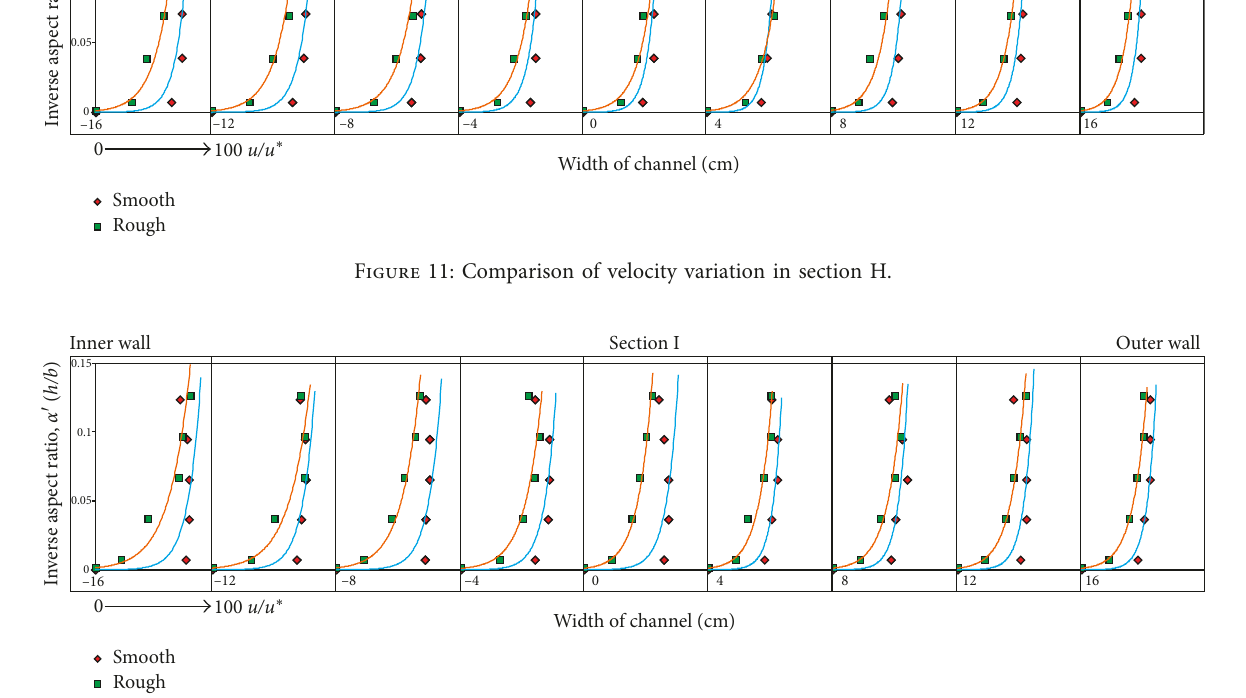
Figure 12: Comparison of velocity variation in section